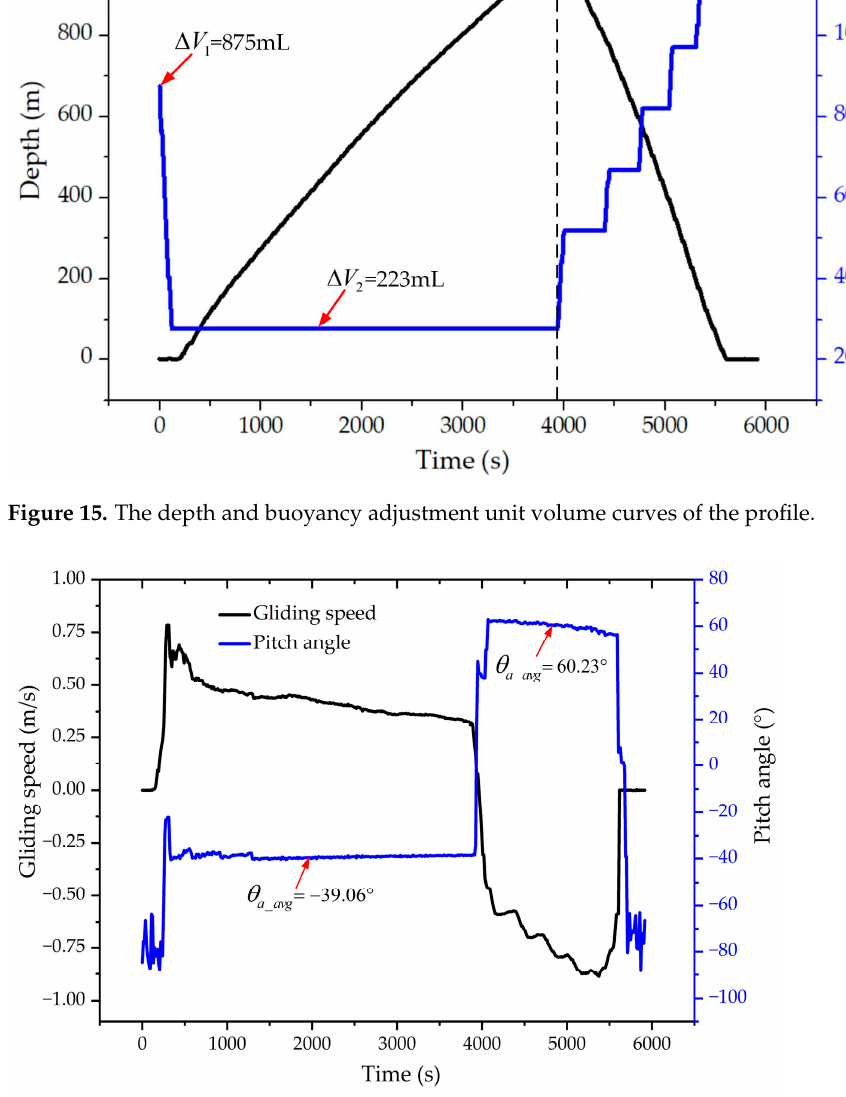
Figure 16. The gliding speed and pitch angle curves of the profile.